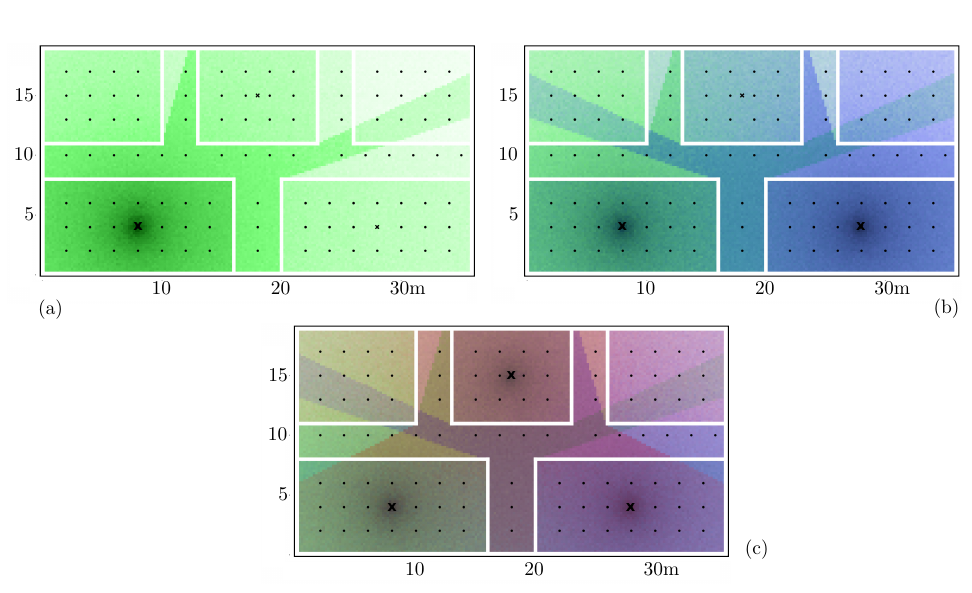
Figure 5. SmartCampus Architecture: a complete, large-scale, indoor positioning system testbed. All beacons send a Bluetooth advertisement packet every second. These packets are received by the scanners, that forward the data to the gateway using a 900MHz, long-range, communication. The gateway sends the data to the central server, which can localize all of the beacons using the proposed graph-based technique. devices each sending one advertisement packet per second. Thus, a single reference 363 point was trained in about 2-3 minutes, which is important when considering the 488 364 reference points that needed to be trained. The whole school was trained in about 5 days. 365